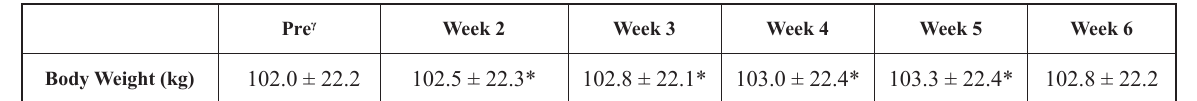
Table 2. Weekly body mass (mean ± SD )